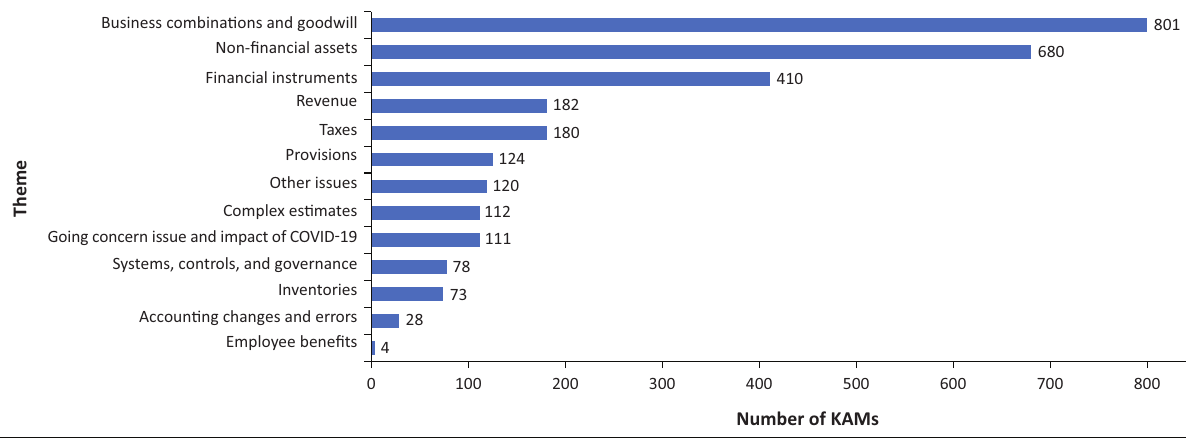
FIGURE 2: Number of key audit matters per core disclosure theme.